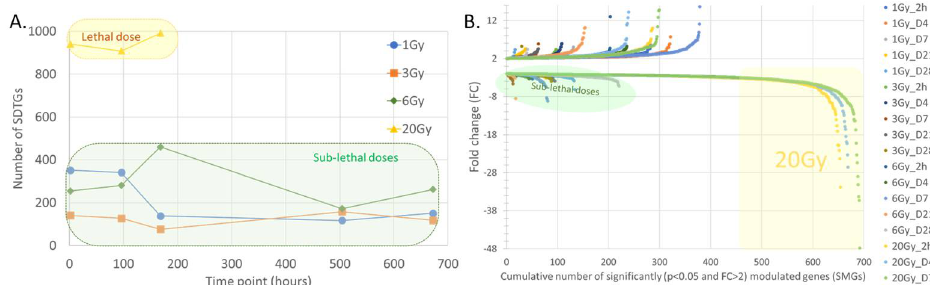
Figure 3. Longitudinal profile of significantly differentially transcribed genes (SDTGs, p < 0.05 and FC ≥ 2) after irradiation with 1, 3, 6, or 20 Gy. Dynamics of SDTGs during the experiment time course ( A ). Dot plot showing the number and magnitude of the regulation (up- and downregulated genes are separated) in SDTGs at all doses and time points ( B ).